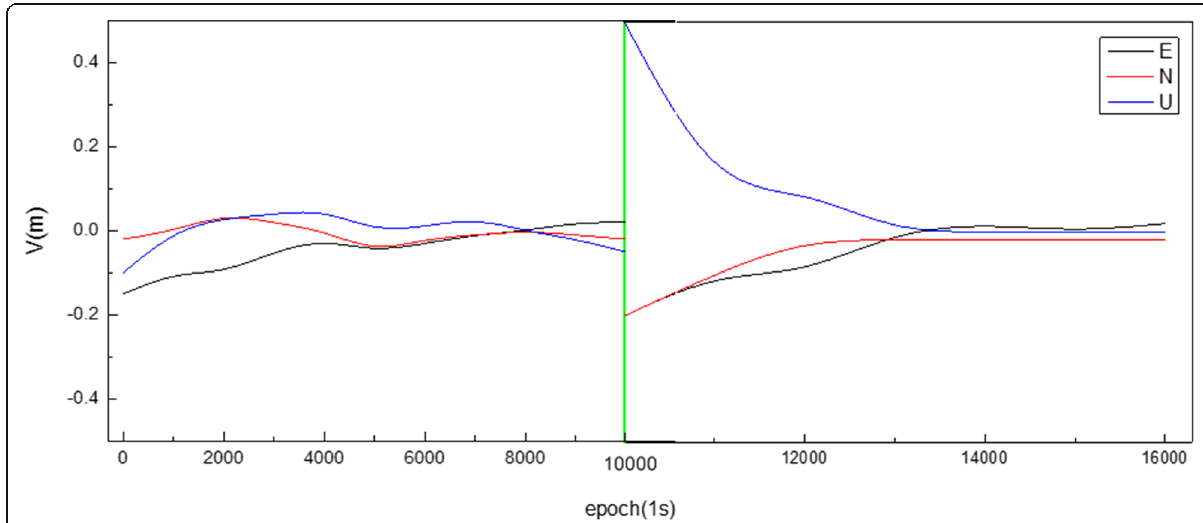
Fig. 7 Dynamic positioning deviation and RMS value of case 1 (with gross error)